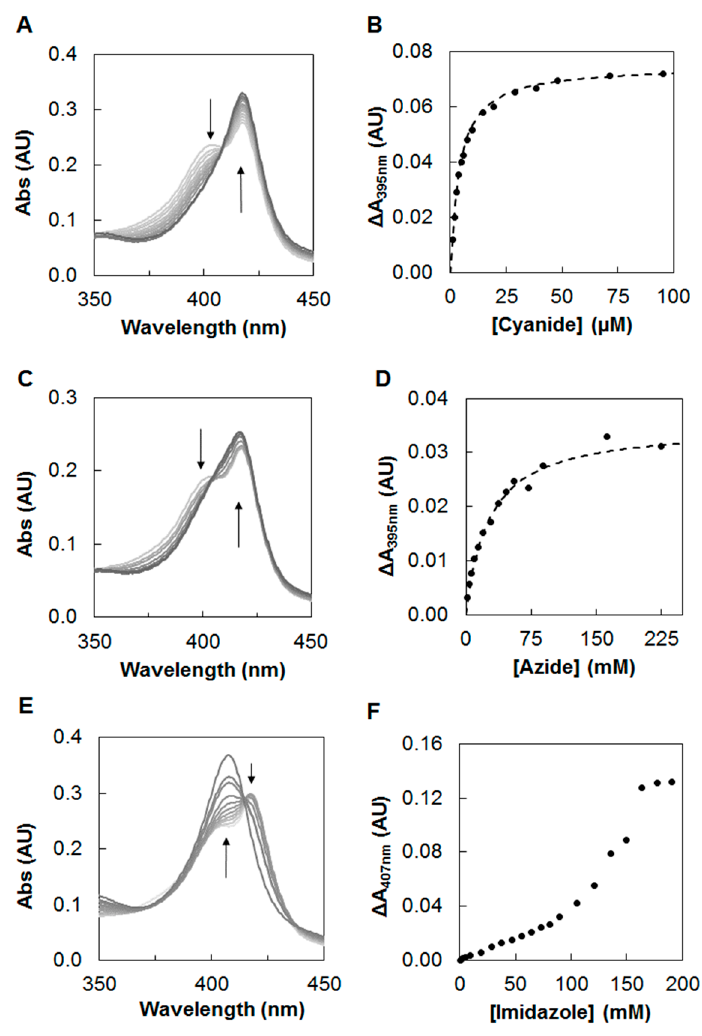
Figure 1. UV-visible spectra of mixed-valence Ng BCCP at pH 7.5 in the presence of increasing con- centrations of cyanide ( A ), azide ( C ) and imidazole ( E ). The arrows indicate the direction of changes in the spectra from the light gray (no inhibitor) to dark gray (maximum inhibitor concentration). The absorption difference at specific wavelengths was plotted as a function of inhibitor concentration in solution (( B ), cyanide; ( D ), azide; ( F ), imidazole). The dashed line ( B , D ) in the binding of cyanide and azide was fitted with a single binding site equation, with a K app of 4 µ M and 26 mM,